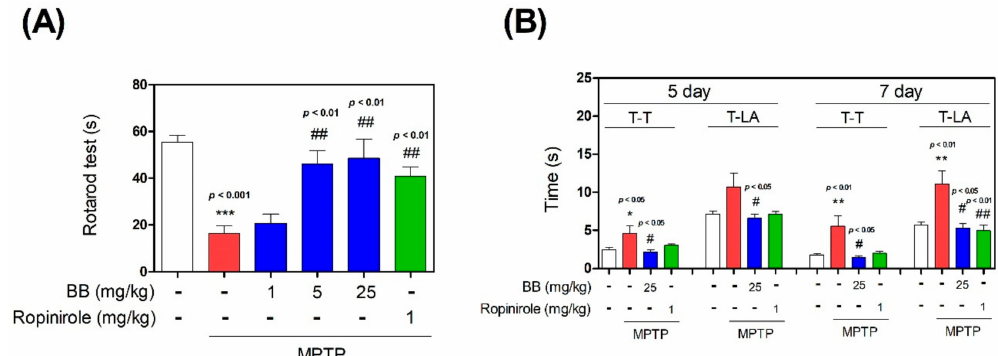
Figure 1. Effects of Batryticatus Bombyx (BB) on 1-methyl-4-phenyl-1,2,3,6-tetrahydropyridine (MPTP)-induced behavior impairment. One day after MPTP treatment, the retention time on the rotating rod was recorded ( A ). On days 5 and 7 after MPTP treatment, time to turn (T-T) completely downward and time to fall off the rod onto the floor (T-LA) were recorded ( B ). Values represent means ± standard error of the mean (S.E.M.). * p < 0.05, ** p < 0.01, and *** p < 0.001 compared with the control group, and # p < 0.05 and ## p < 0.01 compared with the MPTP-treated group.